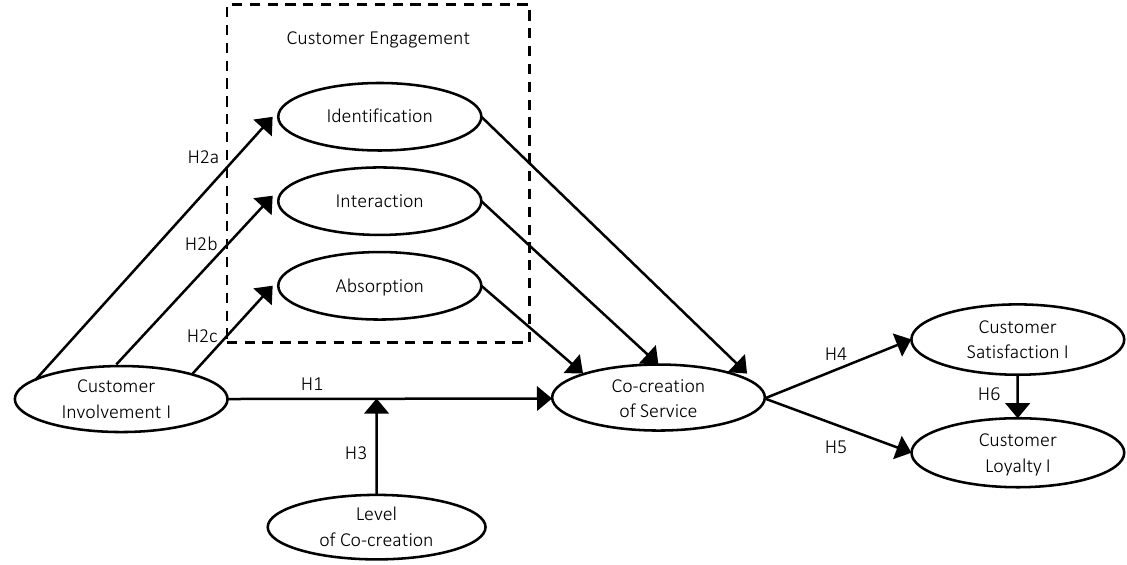
Figure 1. Research